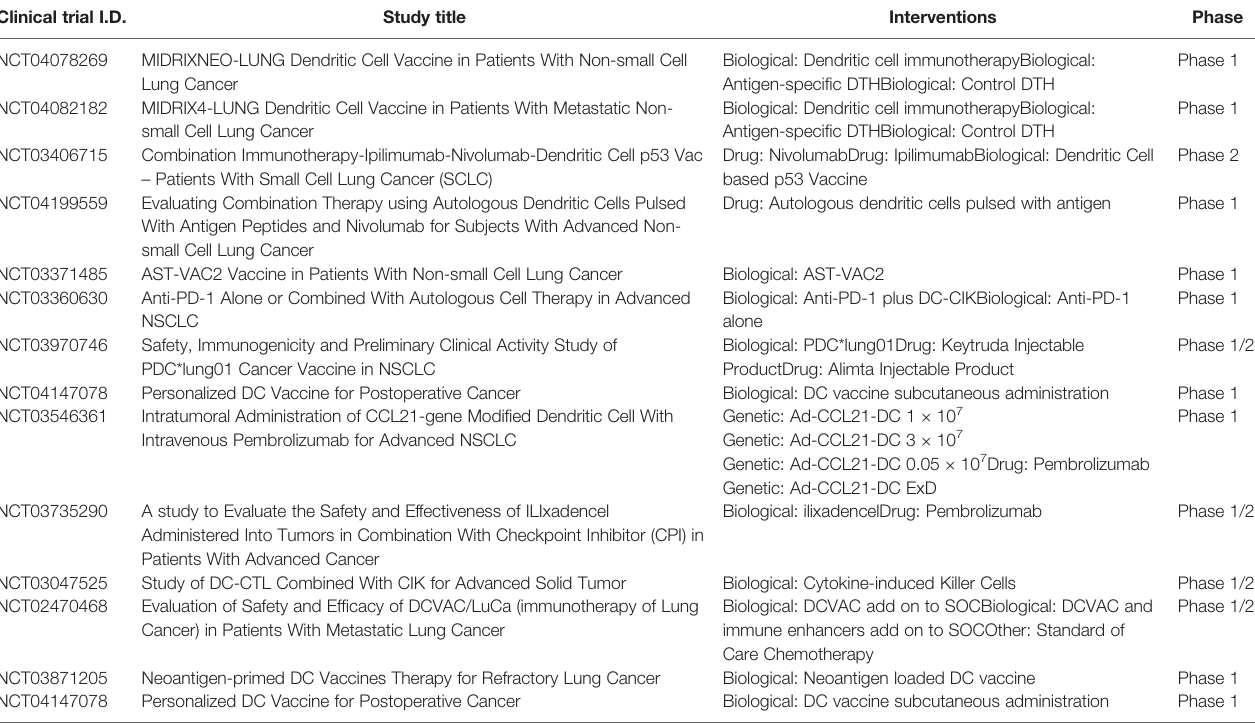
TABLE 3 | Current clinical trials exploring dendritic cell (DC)-based immunotherapy in lung cancer. Clinical trial